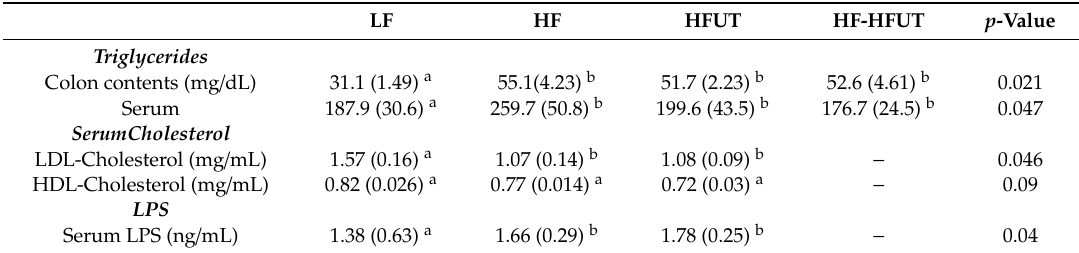
Table 2. Serum and colon content